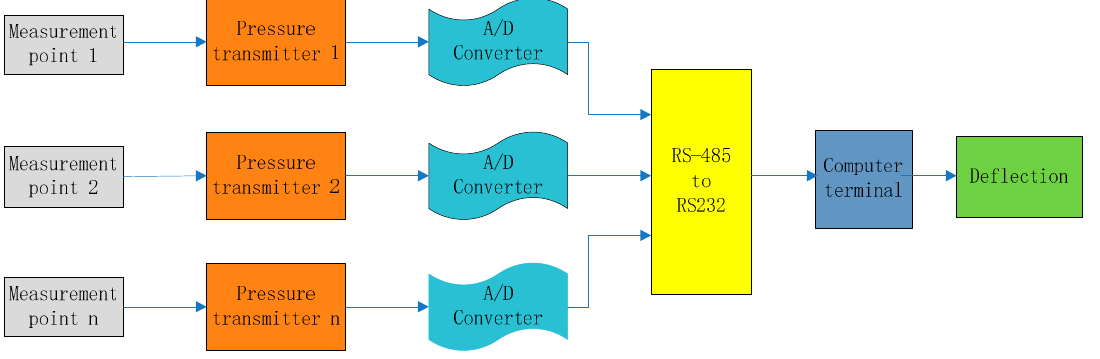
Figure 8. Data acquisition system.